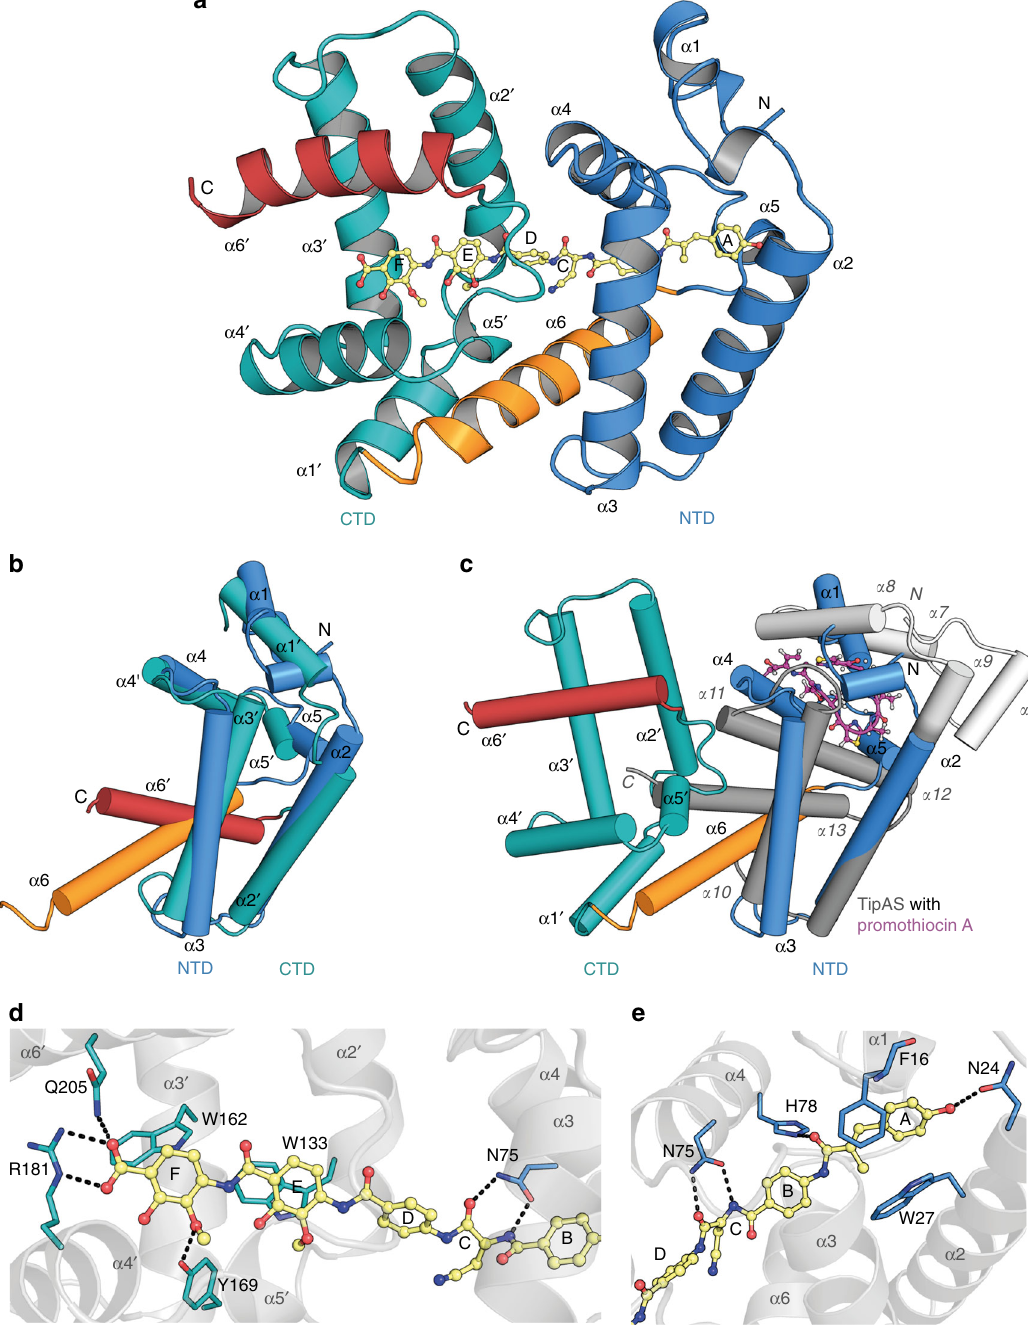
Fig. 5 Structure of the AlbAS – albicidin complex and key residues of AlbAS for albicidin binding. a AlbAS is shown in cartoon representation with the NTD ( α 1- α 6) in blue and the CTD ( α 1 ′ - α 6 ′ ) in cyan. The elongated helix α 6 connecting both domains is highlighted in orange. Albicidin is shown in ball-and-stick representation (yellow) and pervades both domains of AlbAS. b Superposition of the NTD and CTD of AlbAS. α -helical elements are labeled (a prime indicates assignment to the CTD). The protruding helix α 1 of the NTD is predicted to be part of a longer α -helical linker region of AlbAL, which connects the HTH motif and the drug-binding region of the protein. c Superposition of the AlbAS – albicidin complex (ligand not shown) and TipAS (PDB 2MBZ) 27 bound to promothiocin A (ball-and-stick representation, carbon magenta). A region that is unfolded in isolated TipAS and forms an α -helical lid ( α 6- α 9) after drug binding is colored in white. Helices present in the unbound form of TipAS are drawn in dark gray. d Interactions of the AlbAS CTD with albicidin portion D- E-F. e Interactions of the AlbAS NTD with albicidin portion A-B-C. Residues of the NTD, the CTD, and albicidin are colored in blue, cyan, and yellow, respectively, with oxygens in red and nitrogens in blue. Hydrogen bonds and ionic interactions are indicated by dashed